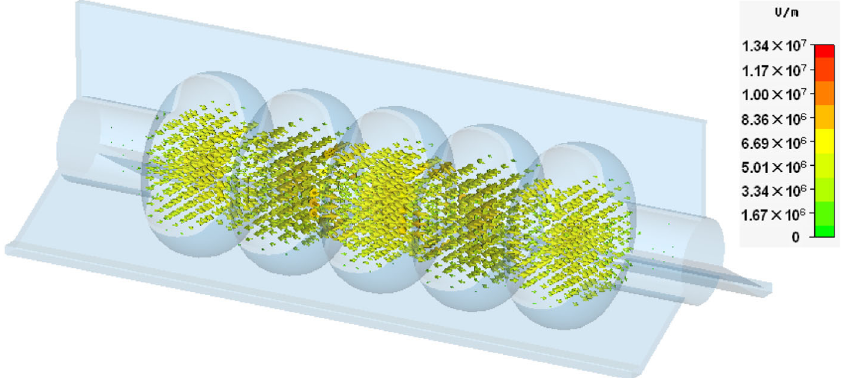
FIG. 7. (Color) E -field of the accelerating (cid:3) mode in the slotted cavity. Frequency ¼ 1 : 4061 GHz , Q e ¼ 7 : 25 (cid:5) 10 11 , R=Q ¼ 464 (cid:1) . The electric field is derived by assuming 1 J stored energy of this (cid:3) mode in the